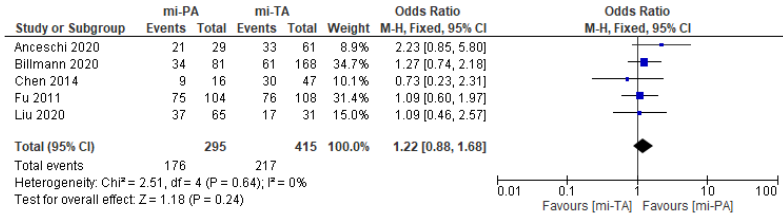
( d ) Forest plot representing analysis of patients with no ‐ standardized complete clinical success. Figure 3.